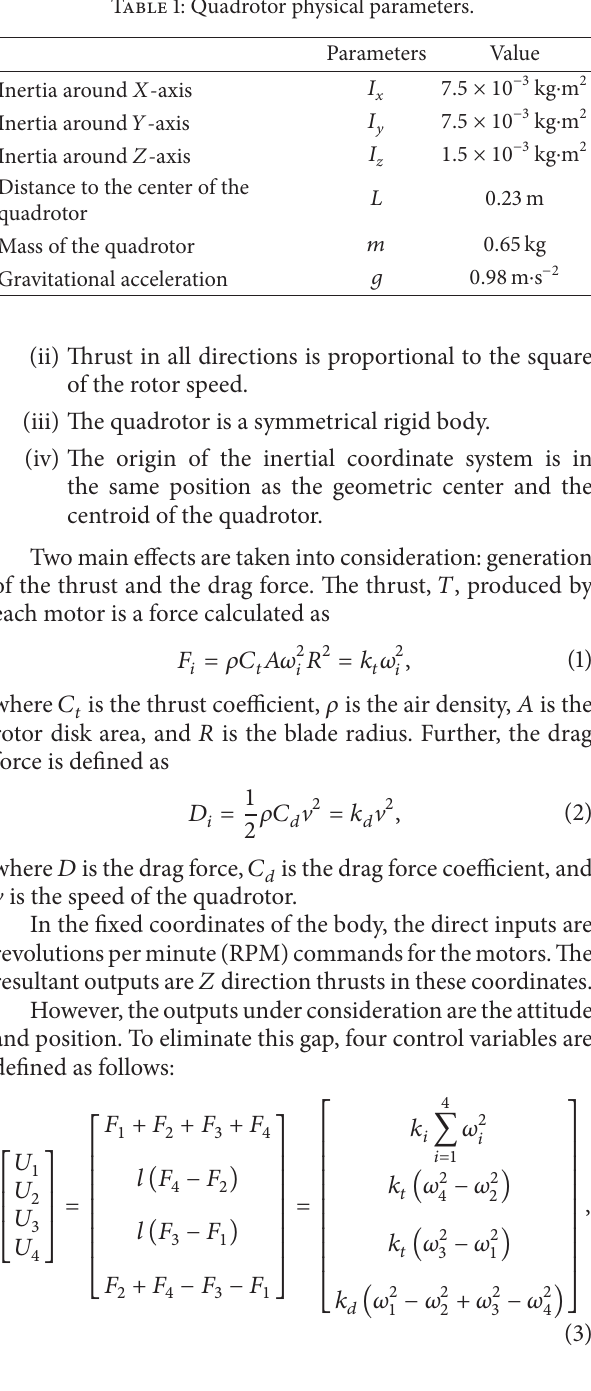
Figure 2: Physical appearance/shape of a quadrotor. Table 1: Quadrotor physical parameters. Figure 3: Definition of axis and rotor output.